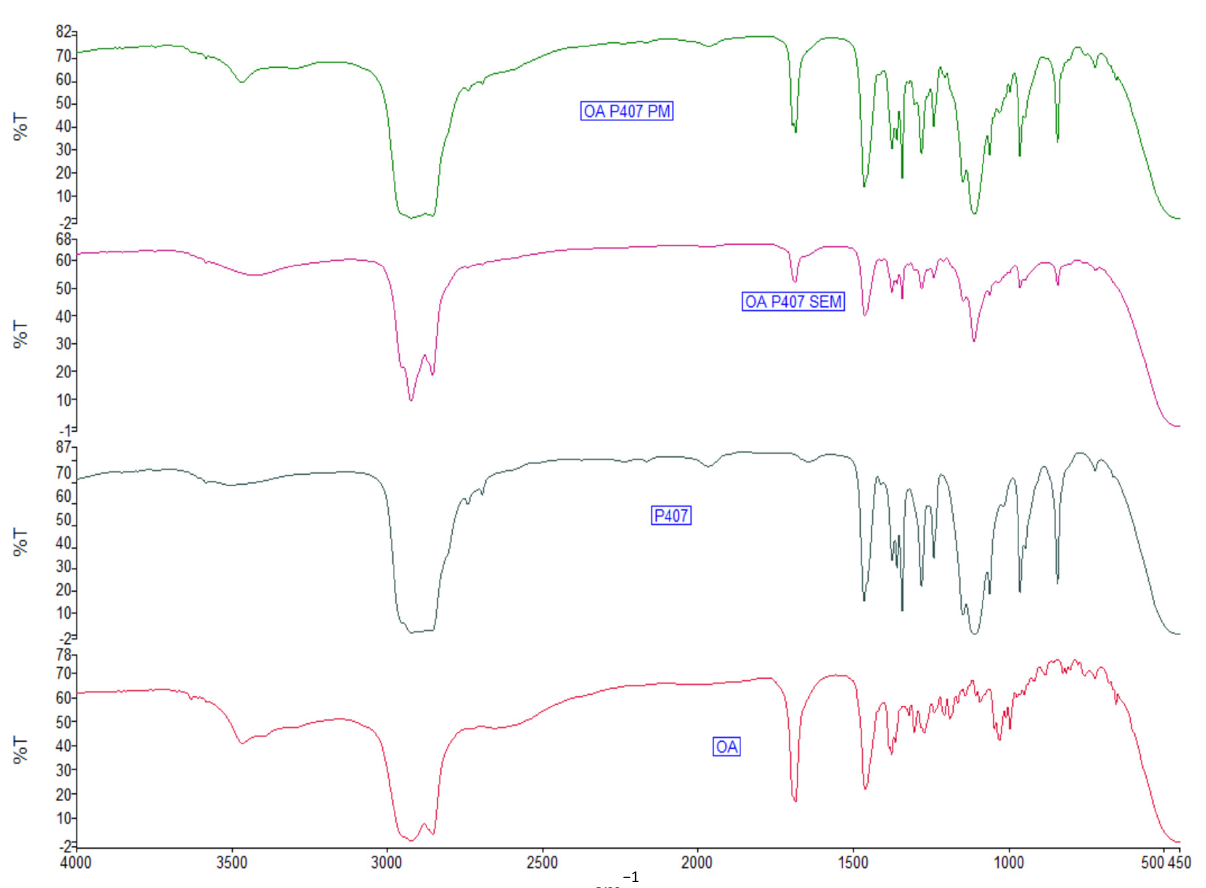
Figure 4. FTIR spectra of OA, P407, physical mixture (PM), and solid dispersion (SEM).